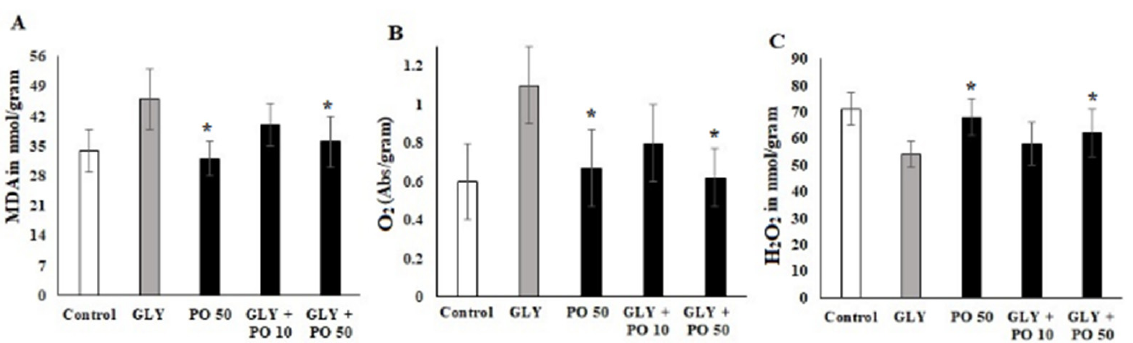
Figure 2. Tomato plants untreated (Control) or treated with GLY, PO 50, or a mix of both (GLY + PO 10; GLY + PO 50). ( A ) MDA, ( B ) O 2 and ( C ) H 2 O 2 concentration. Data presented are mean ± SD ( n ≥ 4). * indicate significant statistical differences between treatments and GLY-treated plants (Tukey’s test: p ≤ 0.05). Black bars indicate the treatment with PO and GLY+PO, the grey bar indicate GLY treatment and the white bar indicates the untreated control.